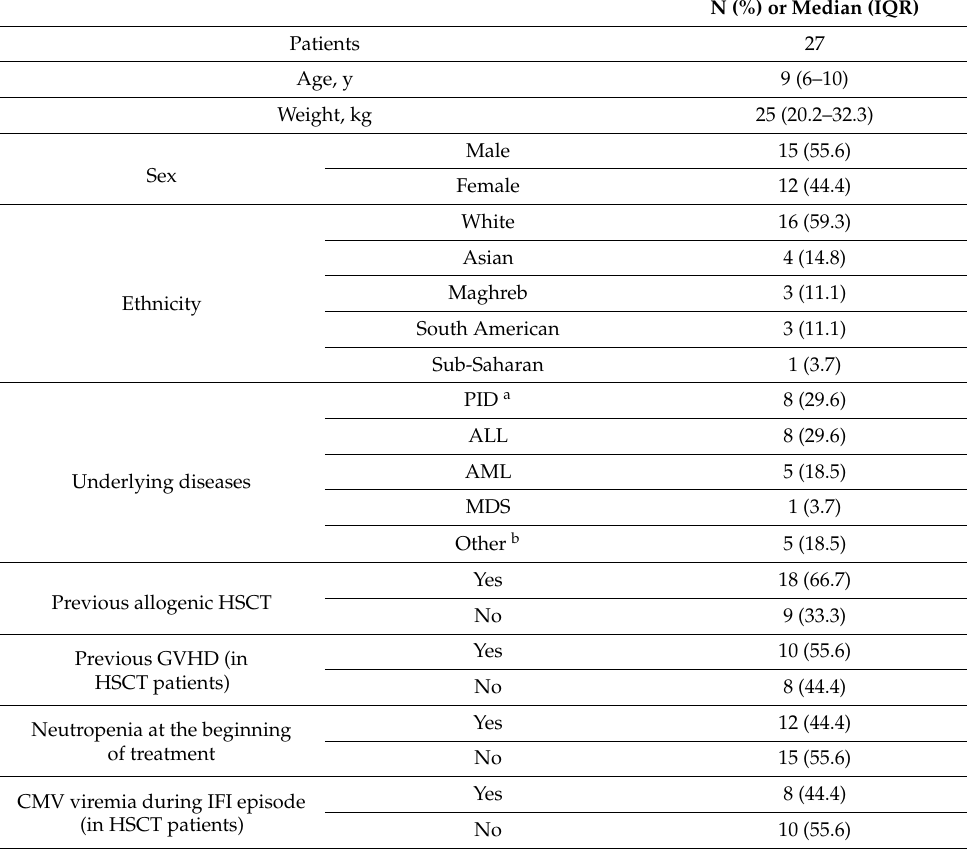
Table 1. Baseline patient